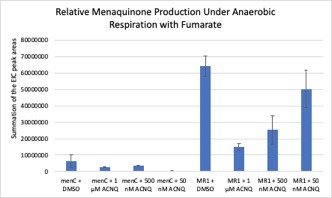
Menaquinone analysis of S. oneidensis menC::Tn10 (menC) and S. oneidensis MR-1 (MR-1) cell pellets when grown with 0.05, 0.5, and 1 μM of ACNQ supplemented to the media under anaerobic conditions with fumarate as the sole TEA.No evidence of ACNQ being converted to menaquinone or being prenylated to form an amino-modified menaquinone was observed.